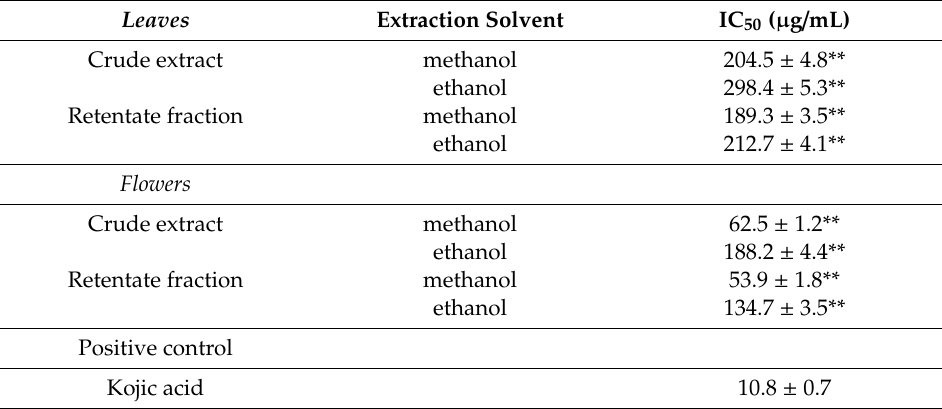
Table 5. In vitro tyrosinase inhibitory activity of S. nigra leaf and flower